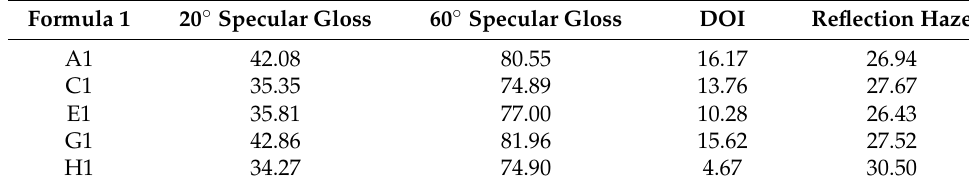
Table 13. The coating surface quality results of coatings prepared by Formula 1. Formula 1